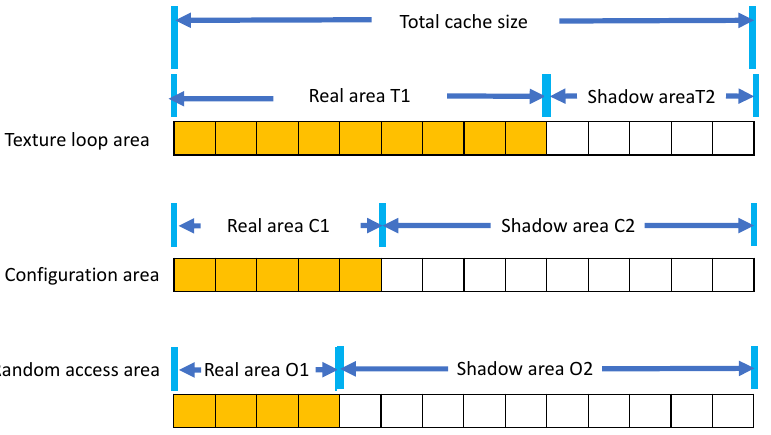
Figure 5. The data structure of the proposed buffer cache.